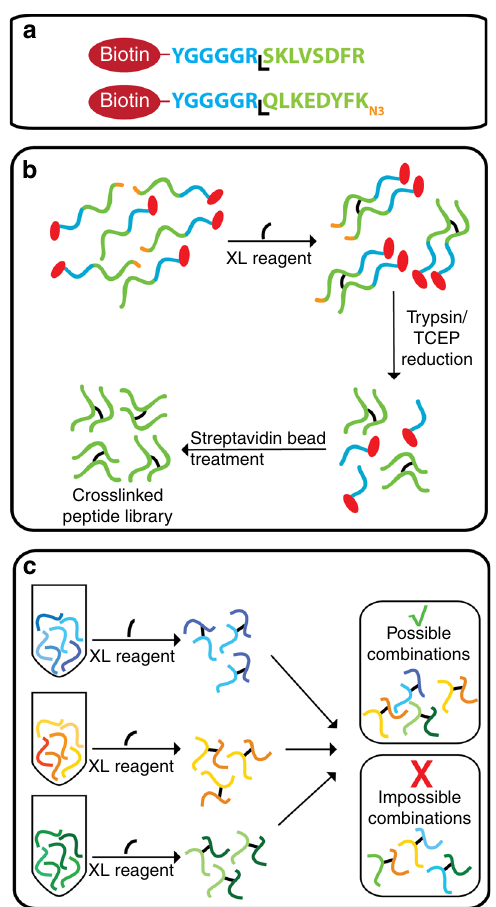
Fig. 1 Design of the crosslinked peptide library. a the N-terminal amine group is protected from crosslinking with a biotin group that is followed by a linker region with a tryptic cleavage site. C-terminal lysine residues are incorporated with an azide group to prevent crosslinking to this site. b Peptides are crosslinked, treated with trypsin and the azide groups on the C-terminal lysine residues are reduced to an amine. Biotin-linker groups are removed from the solution with streptavidin beads. c The synthetic peptides are crosslinked in separate groups and combined prior to LC-MS